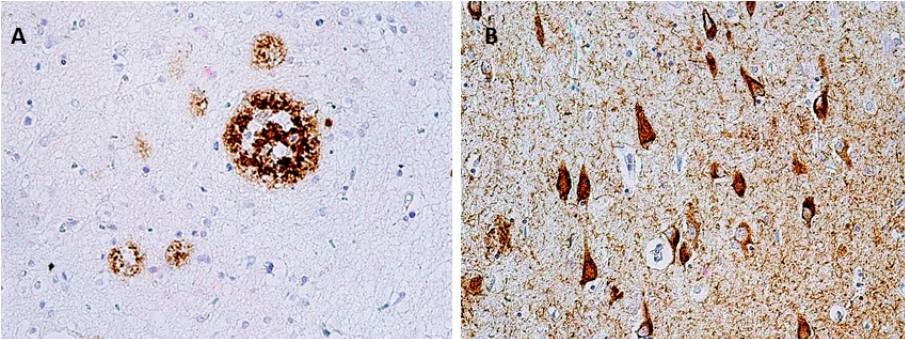
Figure 1. Neuropathological finding showing changes in Alzheimer’s disease. ( A ) Senile plaques in temporal cortex, immunohistochemically stained with β -amyloid antibodies, magnification 400×; ( B ) Neurofibrillary tangles, pretangles, and numerous threads in hippocampus, stained with monoclonal antibody (AT8) against phosphorylated tau protein, magnification 400×.